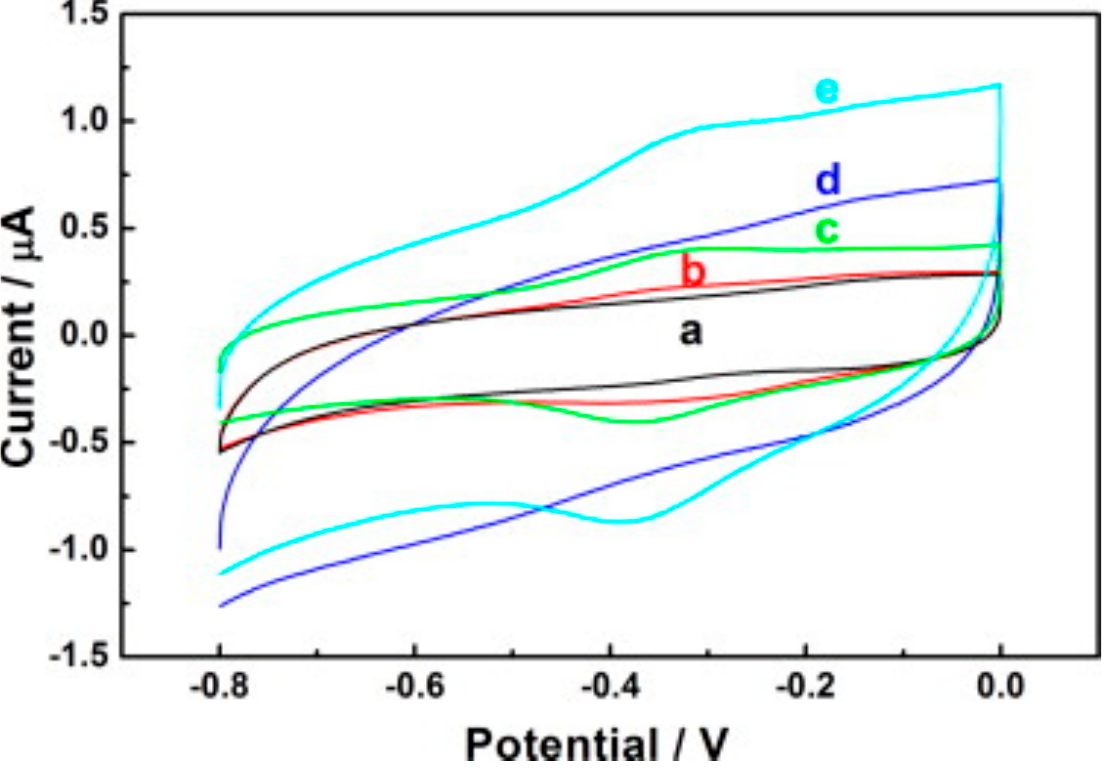
Figure 5. Cyclic voltammograms of ( a ) GCE ( b ) LDHs/GCE ( c ) HRP/LDHs/GCE ( d ) C-Dots/LDHs/GCE and ( e ) HRP/C-Dots/LDHs/GCE electrodes in 0.1 M PBS (pH = 7.0) at a scan rate of 50 mVs − 1 . Adapted from Ref. [93] with authorisation from Elsevier. Table 1. Comparing the analytical performances of HRP/C-Dots/LDHs/GCE with other biosensors. Electrode